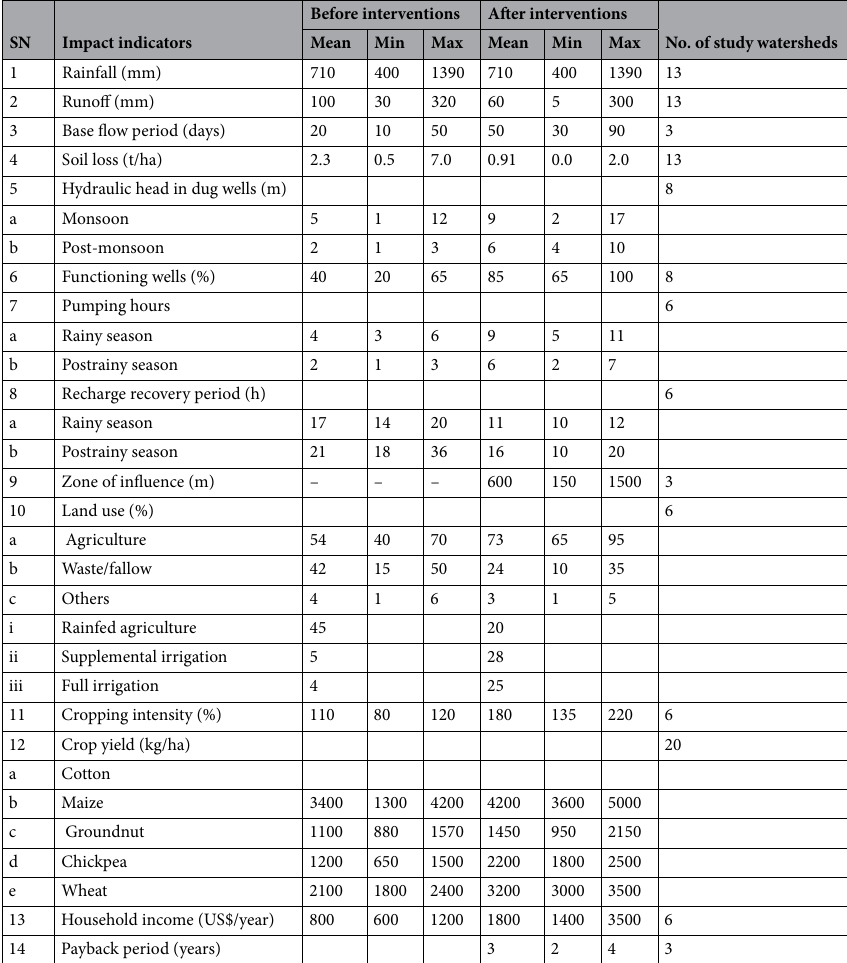
Table 3. Impact of in-situ conservation and ex-situ rainwater harvesting interventions on various ecosystem services.